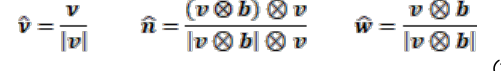
Figure 1. Cartesian coordinate system and moving coordinate system